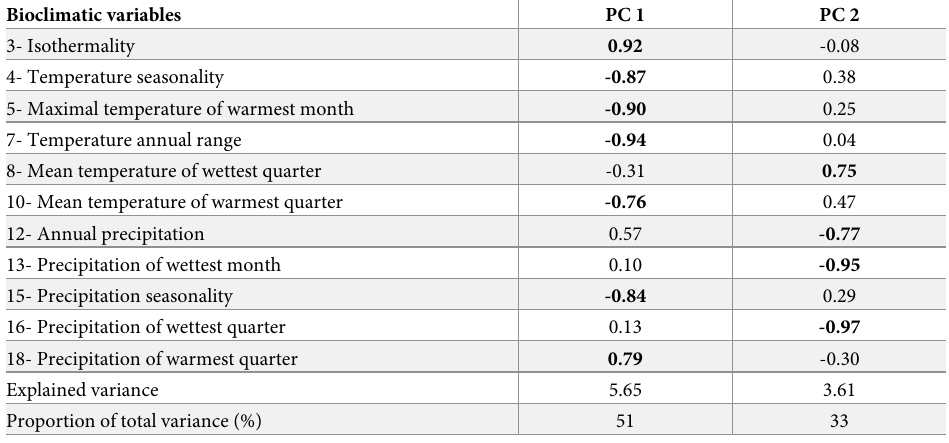
Factor loadings of most important bioclimatic variables onto the first two components (values higher than 0.70 in bold